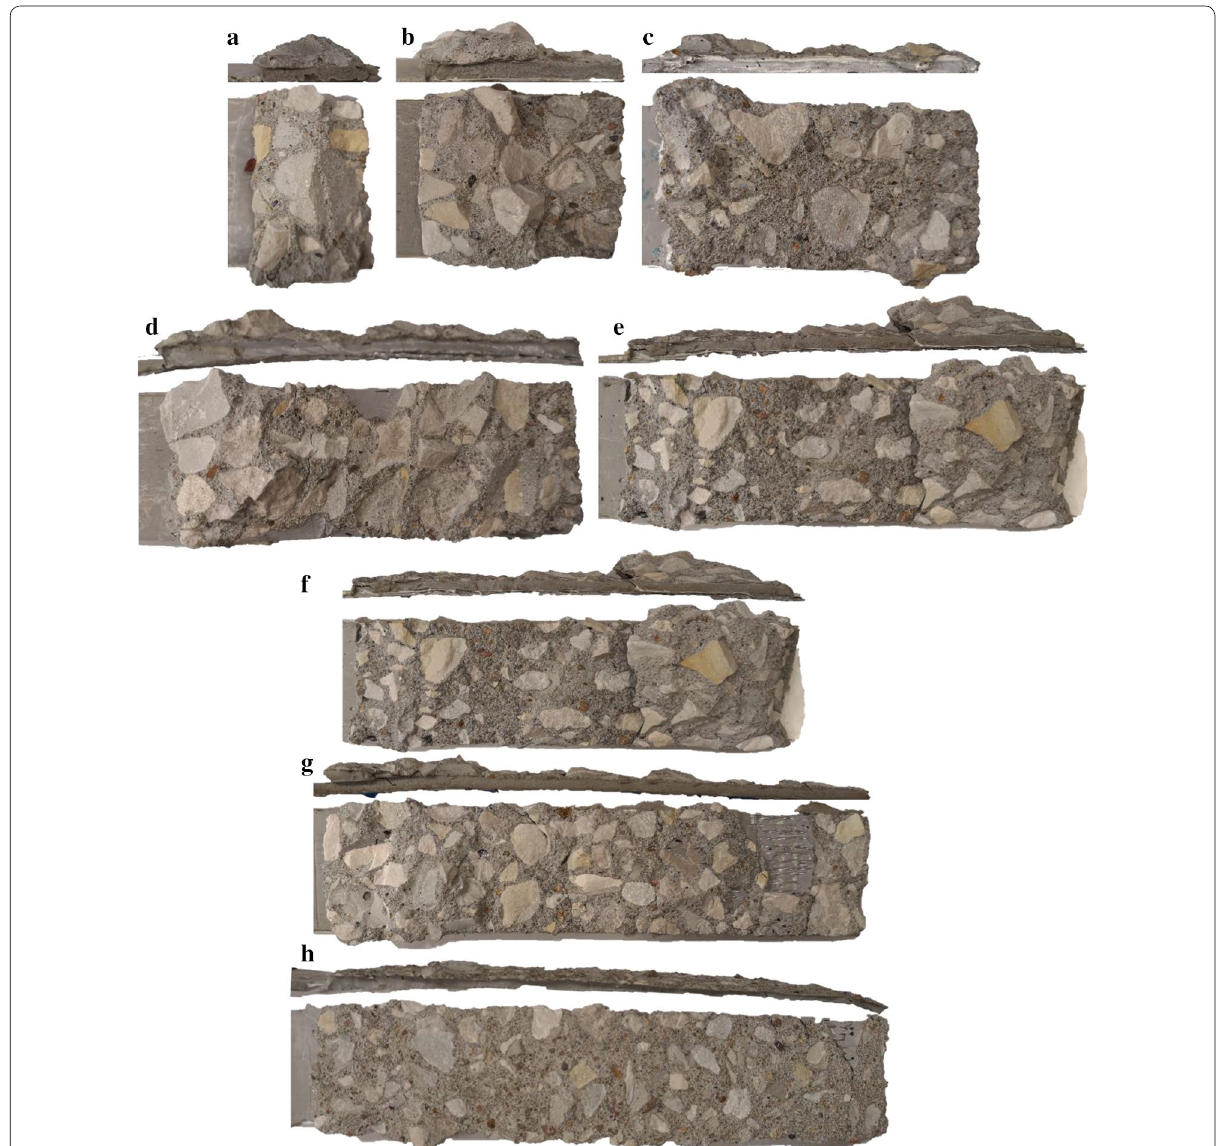
Fig. 5 Typical failure mode of single-lap shear test specimens with MD fibers and bonded length of: a 30 mm, b 60 mm, c 90 mm, d 120 mm, e 150 mm, f 180 mm, g 210 mm, and h 240